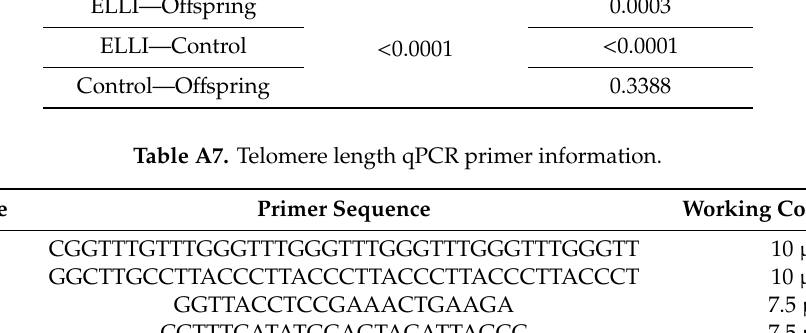
Table A6. One-way analysis of DNAmTL measurements. Table A7. Telomere length qPCR primer information.